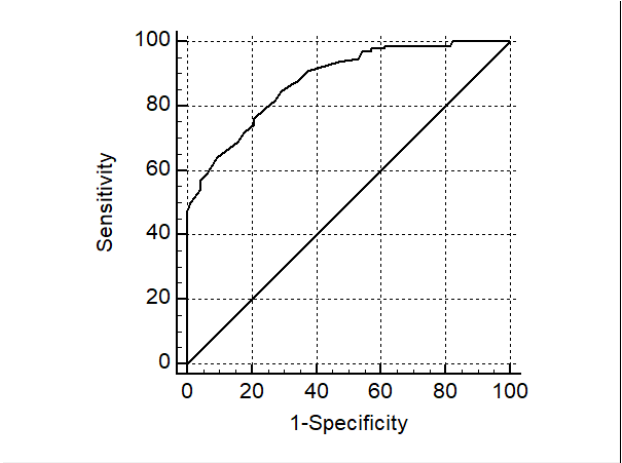
FIGURE 2 - ROC curve was used to evaluate 66 h Methotrexate level as the predictor of toxicities of Methotrexate. The Area under Curve (AUC) is 0.948, P<0.001, indicates good accuracy in predicting toxicities. The optimal cut-off for predicting toxicities was 0.5 μmol/L at 66 h with a sensitivity of 89.09%, that for predicting no toxicity was 0.1 μmol/L with a sensitivity of